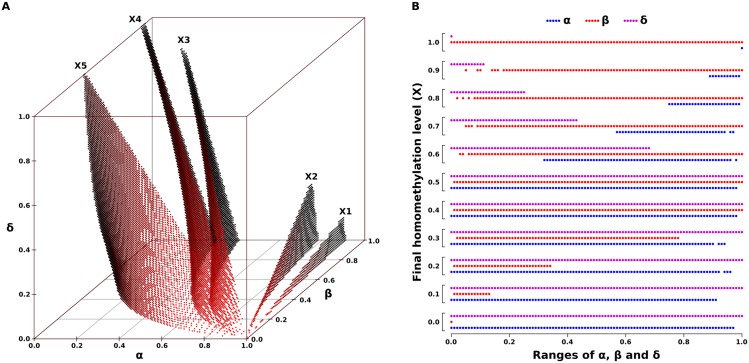
Possible combinations of values of α, β and δ that result in different gametic homomethylation levels (A) and ranges of α, β and δ values which can yield different homomethylation levels (B).(X1) X = 0.91 (e.g. zebrafish sperm), (X2) X = 0.80 (e.g. zebrafish oocytes), (X3) X = 0.54 (e.g. human sperm), (X4) X = 0.48 (e.g. human oocyte), and (X5) X = 0.30 (hypothetical gamete with low methylation level).